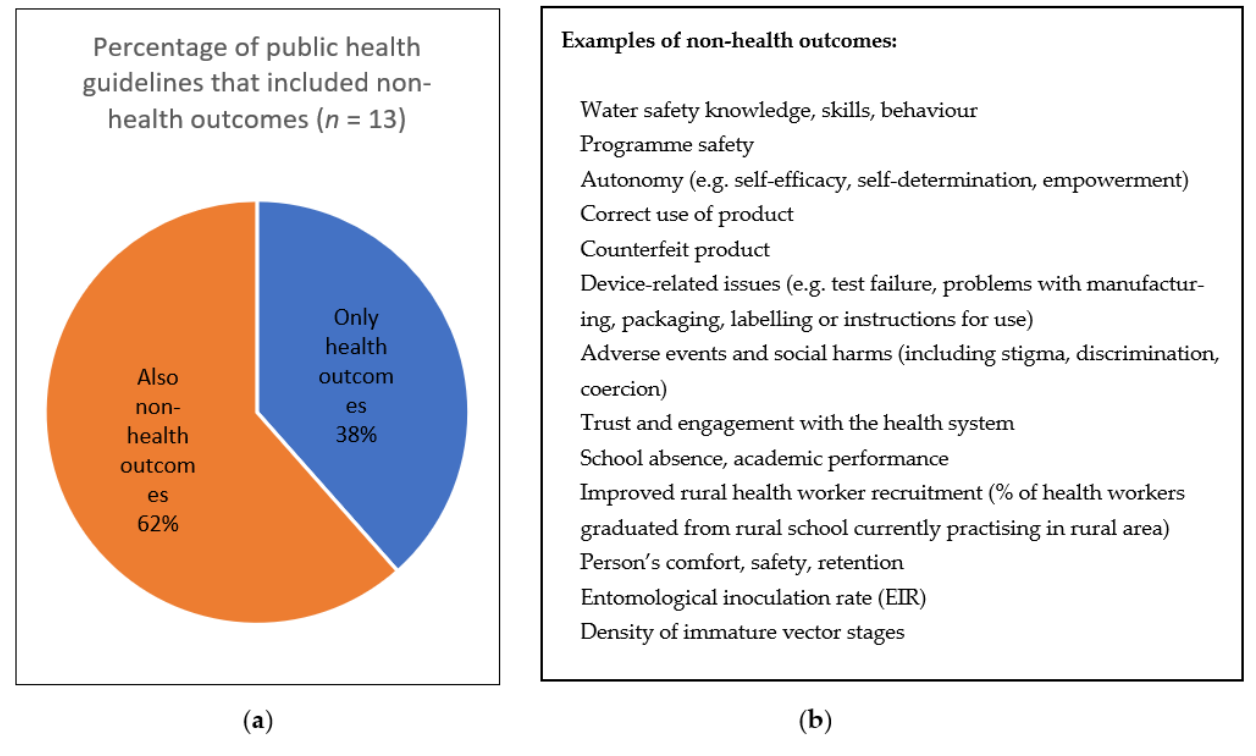
Figure 1. ( a ) Percentage of public health guidelines (n = 13) published in January–August 2021 that included non-health outcomes; ( b ) examples of non-health outcomes in the guidelines.